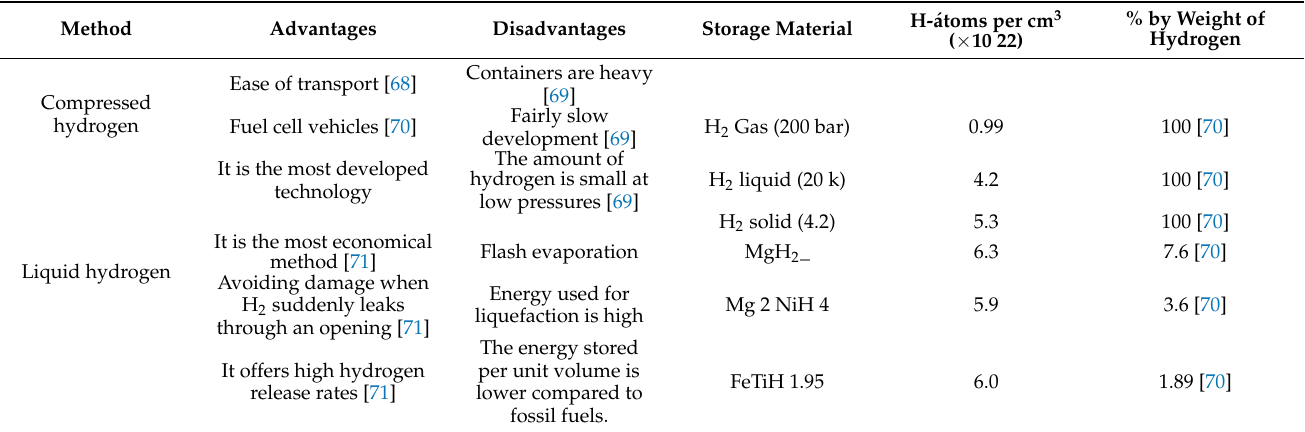
Table 8. Describes the main methods of hydrogen storage systems and their advantages and disad- vantages of the technologies.